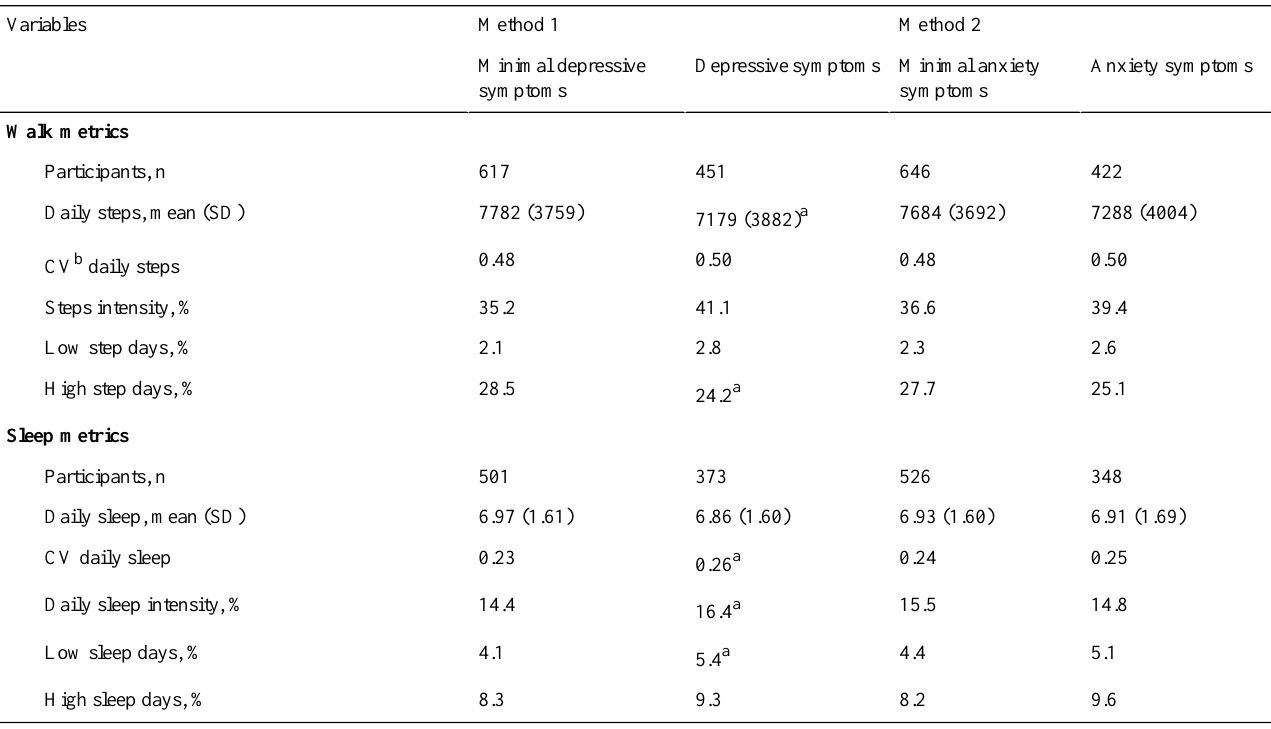
Table 5. Behavioral variables by classification method (Methods 1 and 2).